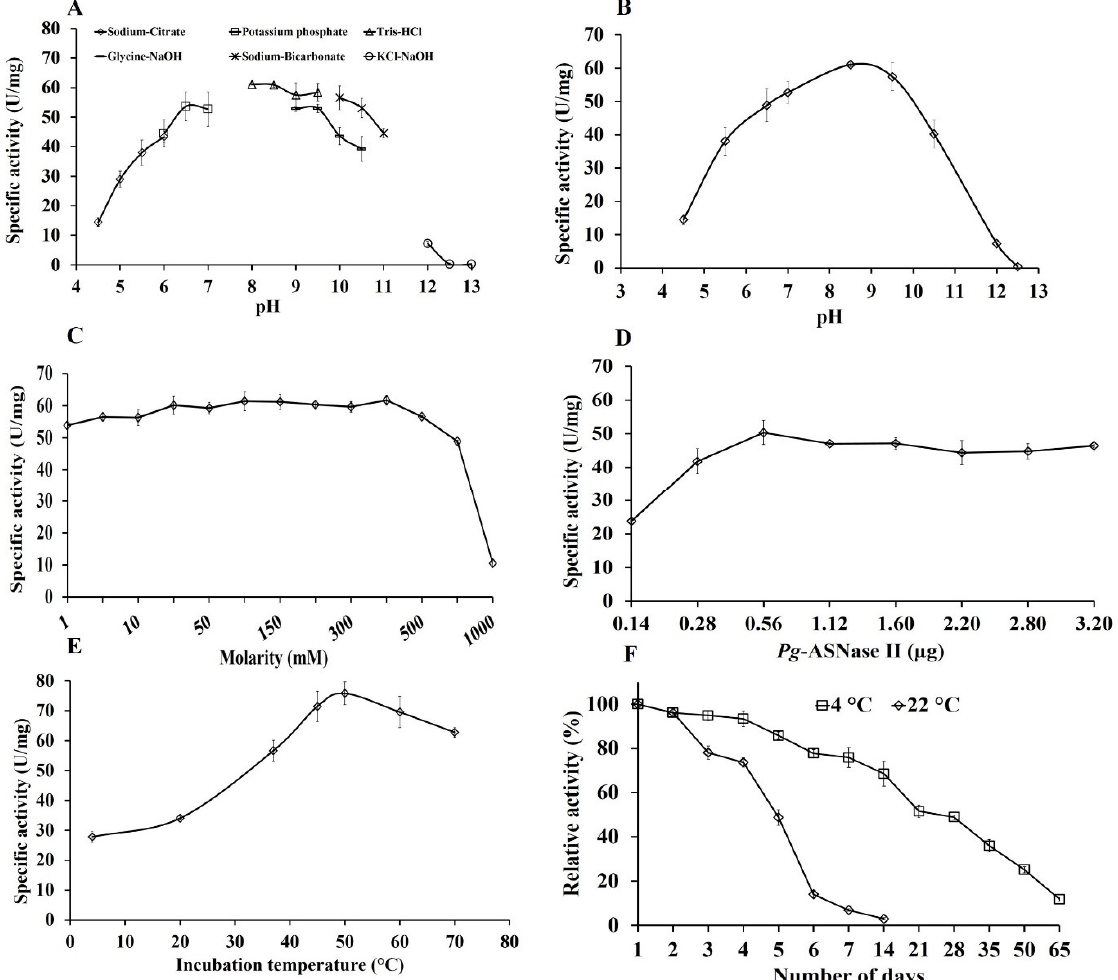
Figure 3. Optimization of different reaction parameters for His-tagged Pg -ASNase II. ( A ) Buffer, ( B ) pH, ( C ) Buffer molarity, ( D ) Enzyme concentration, ( E ) Incubation temperature, and ( F ) Shelf-life of Pg -ASNase II stored at 4 and 22 ◦ C. The error bars represent the standard deviation of three experiments. The enzyme retained 79.8 and 70% of original activity at 37 and 50 ◦ C after 60 min, respectively. At higher temperatures, enzyme activity dropped rapidly and retained 40.13, 22.80, and 15.17% activity after 20 min incubation at 60, 70, and 80 ◦ C, respectively (Figure 4). The half-life of Pg -ASNase II was measured to be 625.15 min at 37 ◦ C with a dissociation constant ( k d ) of 1.10’10 − 3 min (Table